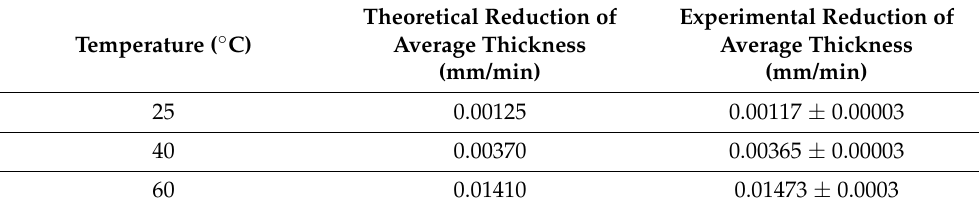
Table 1. Thickness reduction per surface e at 7.5 M as a function of temperature.